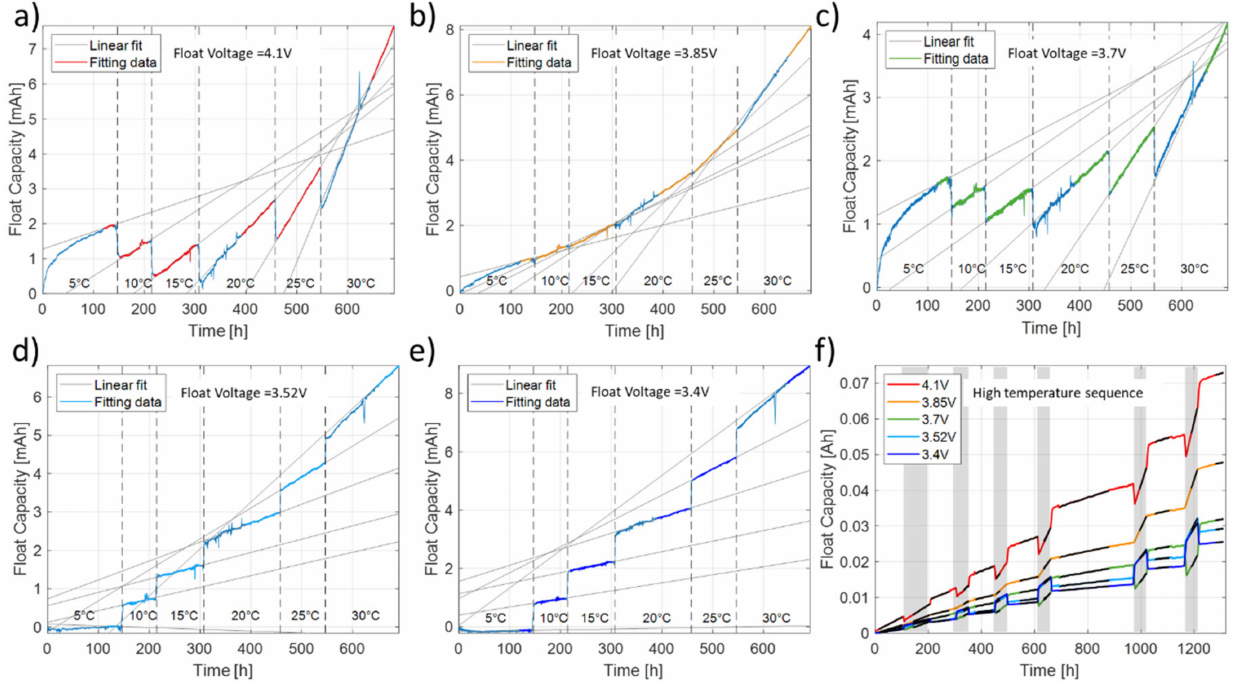
Figure 6. Float capacity over time for the low temperature sequence: ( a ) 4.1 V; ( b ) 3.85 V; ( c ) 3.7 V; ( d ) 3.52 V; and ( e ) 3.4 V; and in ( f ) for all cells in the high temperature sequence. Linear fits in black to the float capacity in the specific color to determine the float current at each temperature. In the specific cell colors, the parts are highlighted that are used for the fitting, avoiding transient and noisy parts. The dashed line highlights a temperature